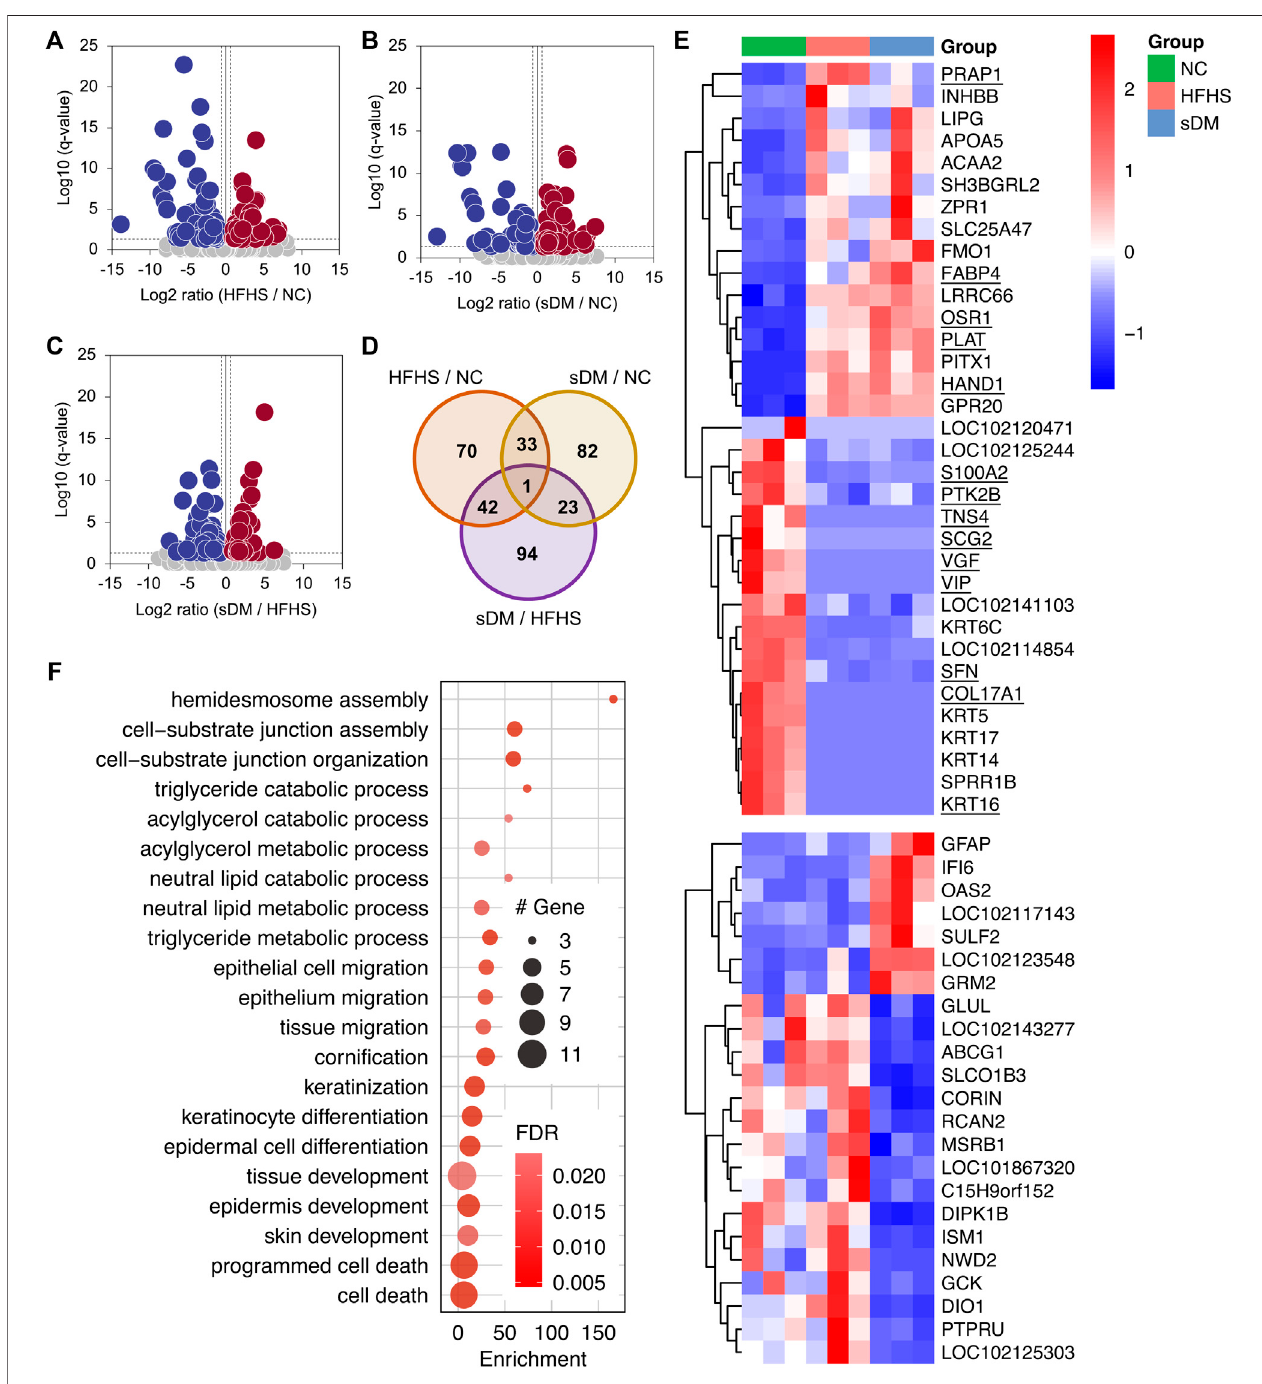
FIGURE3| Theexpressionpro fi leintheliversofthreegroups. (A – C) ThevolcanoplotsofthegenesdifferentiallyexpressedbetweentheHFHSandNCgroups (A) , the sDM and NC groups (B) , and the sDM and HFHS groups (C) . (D) The altered transcripts between every two groups of the monkeys (E) The z-scored expression of thegenesthatsigni fi cantlyregulatedcommonlyinboththesDMandHFHSmacaques(upperpanel)andonlyinthesDMgroup(lowerpanel).Thegenesthathaveknown functionsrelatedtocellmorphologyandcellmovementareunderlined. (F) Fisher ’ sexacttestedGOtermenrichment(biologicalprocess)ofthegenesco-regulated in both sDM and HFHS groups.